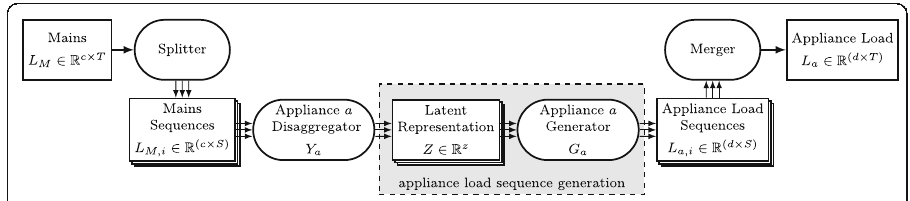
Fig. 1 Information Flow in Neural NILM: The load profile of mains is split into sequences and fed to appliance- specific disaggregators. Later, the partial results have to be merged to form the final result. The gray